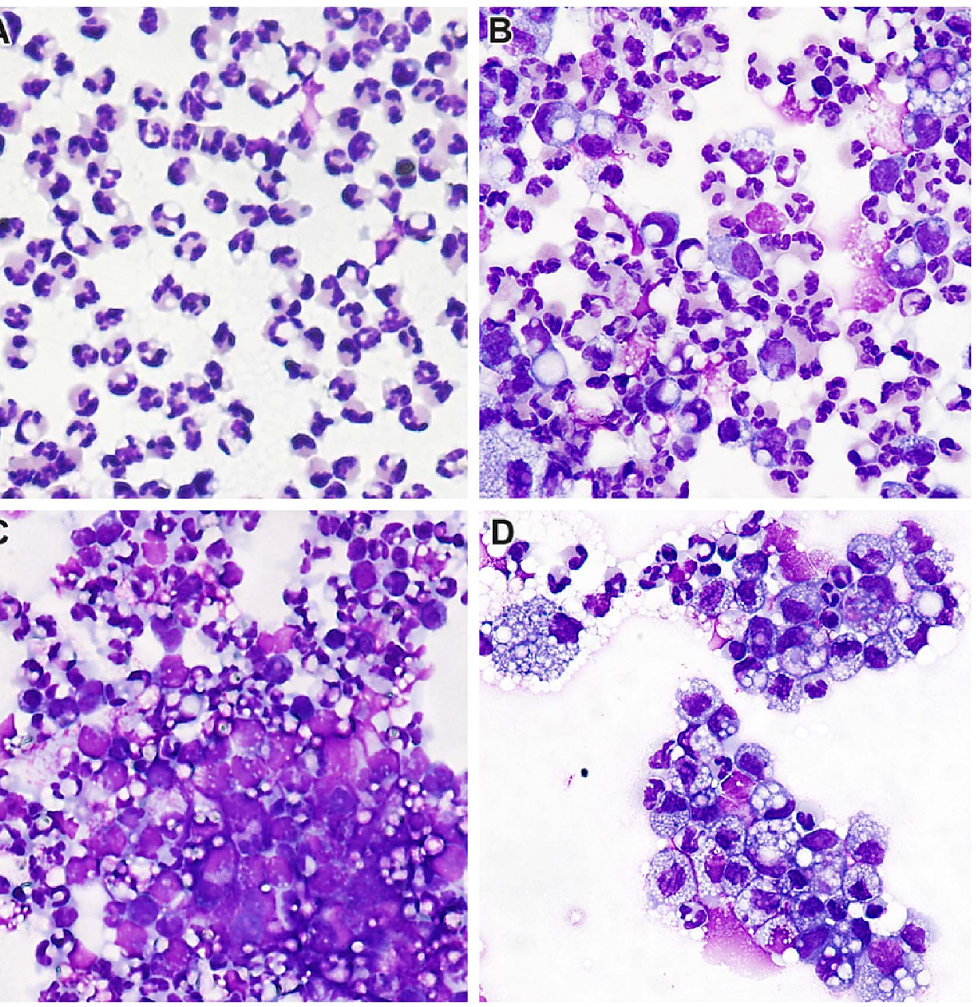
Figure 3. Microscopic examination of milk cells recruited at different times following intramammary infusion with ovalbumin. Milk cells from quarters infused with ovalbumin were cytocentrifuged on glass slides and stained with May-Gru¨nwald-Giemsa. Slides representative of each sampling time are shown. A) 12 hpi; B) 24 hpi; C) 48 hpi; D) 96 hpi;